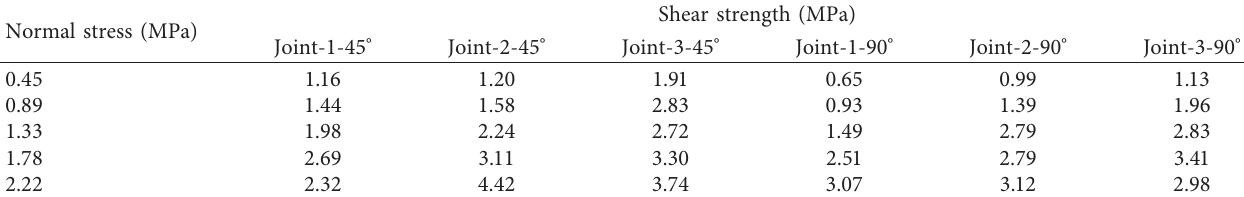
Table 2: Shear strength of joints under different conditions.